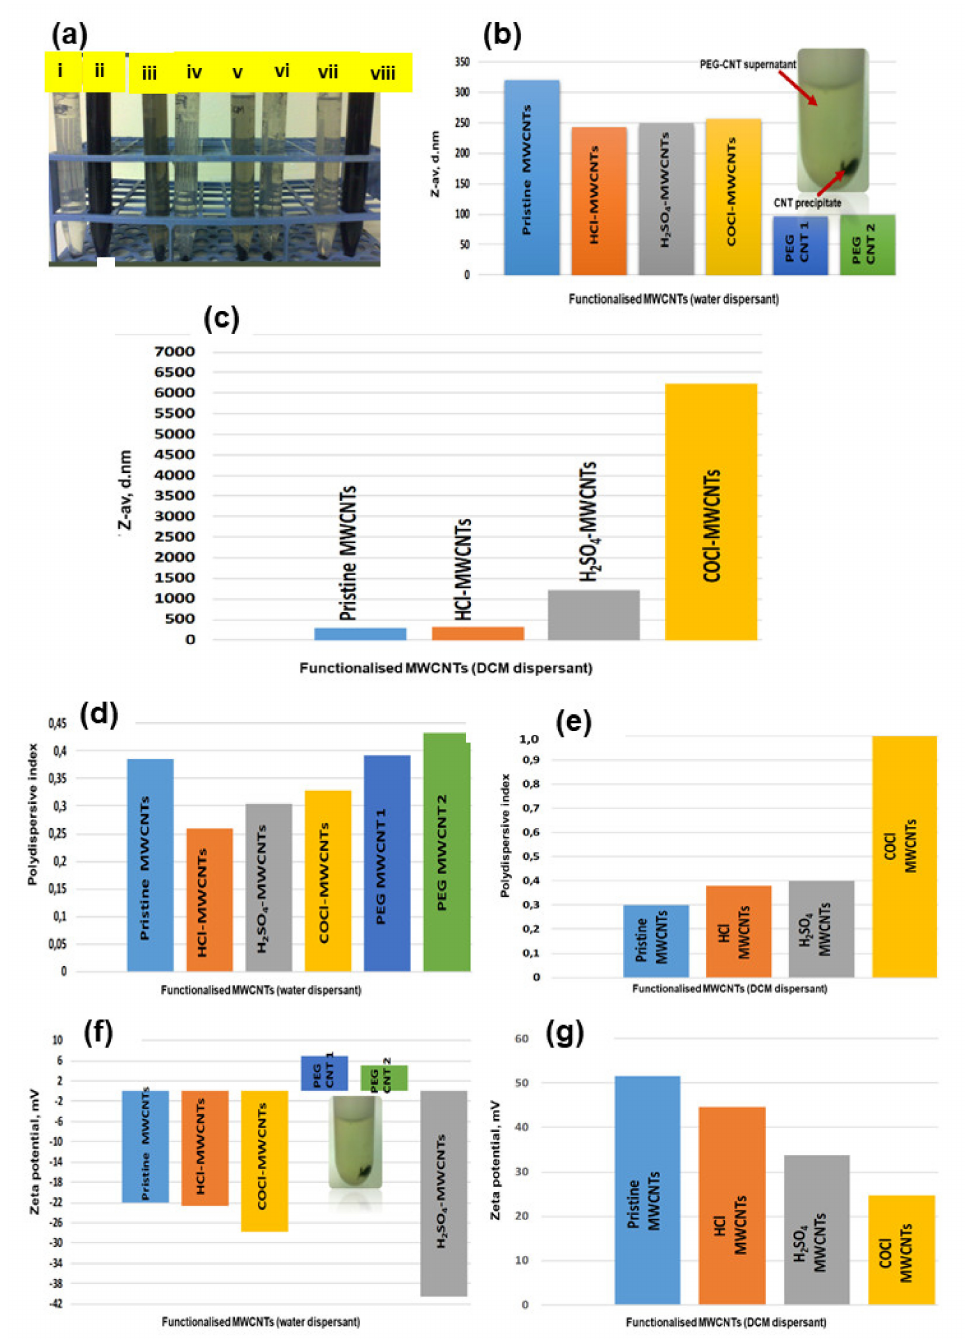
Figure 2. Dispersibility of pristine and functionalized MWCNTs in water and dichloromethane (DCM). COCl-CNTs in DCM ( a )i, COCl-CNTs in water ( a )ii, CNTs in DCM ( a )iii, pristine CNTs in water ( a )iv, HCl-CNTs in DCM ( a )v, HCl-CNTs in water ( a )vi), H 2 SO 4 -CNTs in DCM ( a )vii and H 2 SO 4 -CNTs in water ( a )viii. Particle size distribution (PSD) of CNTs dispersed in water ( b ), CNTs dispersed in DCM ( c ), Polydispersive index (PDI) of functionalized CNTs dispersed in water ( d ) and in DCM ( e ). Zeta potential of CNTs dispersed in water ( f ) and in DCM ( g